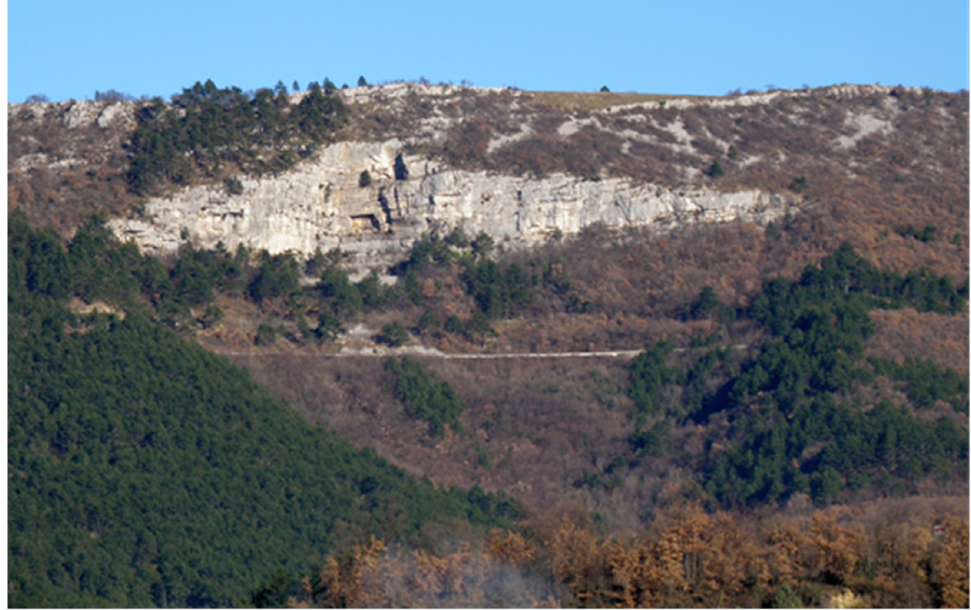
Figure 1. A view of the Raspadalica Cliff, Istria Peninsula, Croatia. The rockfalls threatening the railway line on the slope are clearly visible.